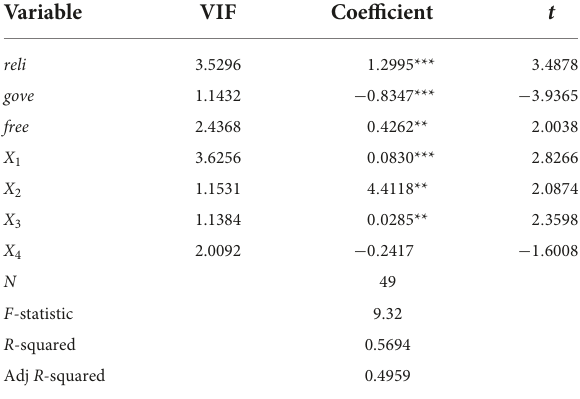
TABLE 3 Baseline regression estimation